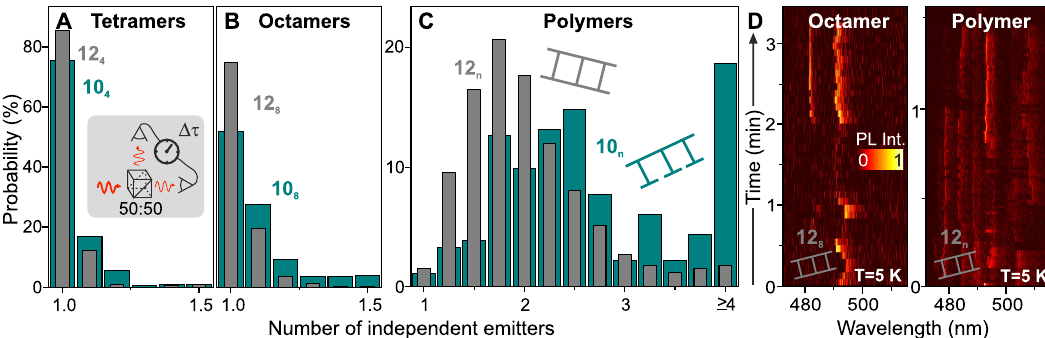
Fig. 4 Number of independent emitting units in open (green) and closed (grey) ladder structures. A – C The number of emitters can be estimated from the temporal correlation of the fl uorescence intensity, by passing the emitted light through a beam splitter and recording the photon coincidence rate on two photodetectors as a function of delay time Δτ . Histograms are shown for approximately 200 single molecules each, demonstrating that single ladder polymers emit fewer than two photons at once even though they contain two separate conjugated strands. D At 5 K, exciton mobility along the chain is reduced, so that individual optical transitions occur at distinct wavelengths. The octamer ladder displays two optical transitions as would be expected from the two conjugated strands. In the polymer ladder, up to six distinct optical transitions are identi fi ed, which can be assigned to independent emitters. This increase in the number of emitting units arises because the conjugation along each strand becomes disrupted when the molecule is frozen in the